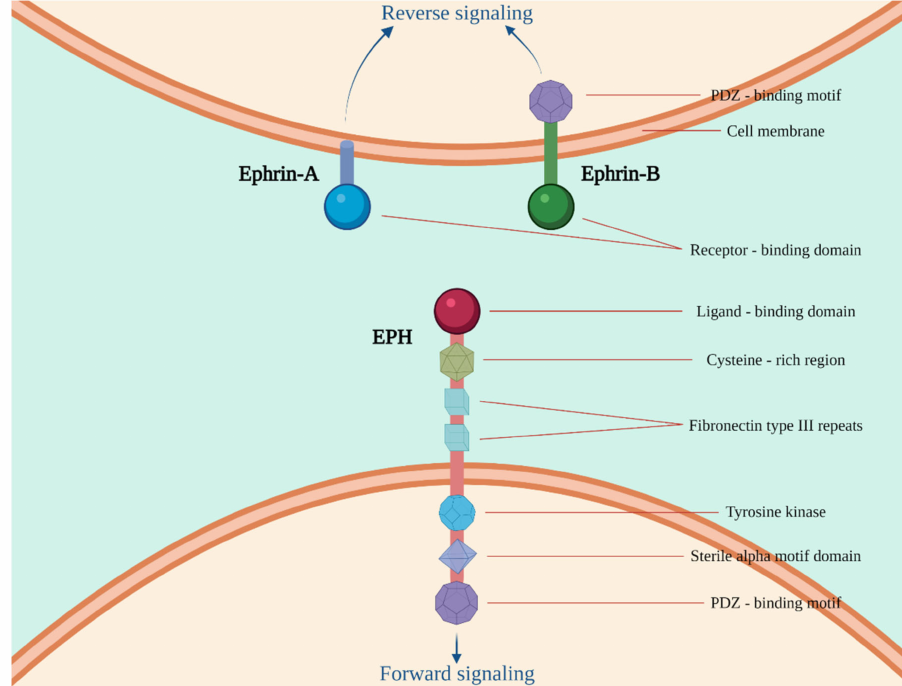
Figure 1. Structure of the erythropoietin-producing hepatocellular receptor (EPH)/ephrin molecules. Ephrin-A ligands are anchored to the plasma membrane by a glycosylphosphatidylinositol an- chor, whereas ephrin-B ligands contain a transmembrane domain and a short cytoplasmatic tail. EPHs/ephrins, upon activation, exert their physiological as well as their tumor-promoting and tumor- suppressive functions through complex molecular pathways inside the cytoplasm. Forward signaling is conducted through EPH’s interaction with a number of different biomolecules and pathways, such as GTPases of the Rho and Ras family, focal adhesion kinase (FAK), and the pathways of the Janus kinase (JAK)-signal transducer and activator of transcription (STAT), as well as the phosphoinositide 3-kinase (PI3K). In backward signaling, upon the phosphorylation of ephrins, different proteins that contain Src Homology 2 (SH2) or PDZ domain, such as Grb4, interact with the ephrin and transmit the signal downstream [14]. Created with